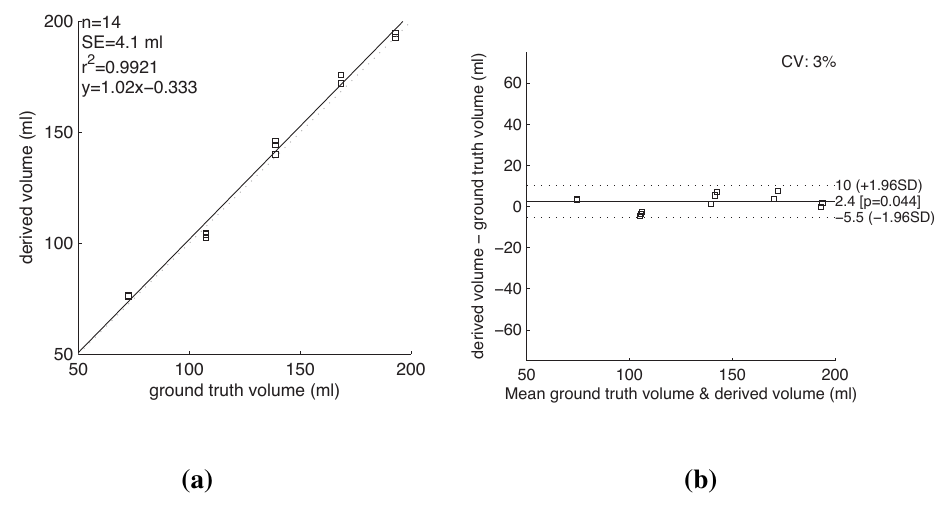
Figure 8. A Bland-Altman plot of the volumetric measurements. This plot was produced in MATLAB using the Bland-Altman function produced by Ran Klein